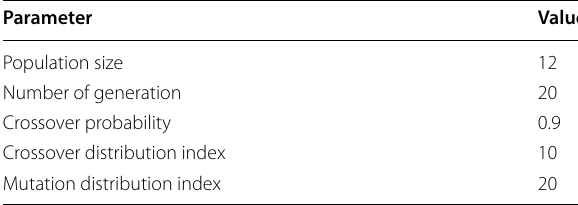
Figure 17 Iteration processes of four follower optimizations Table 8 Configuration parameters of NSGA-II